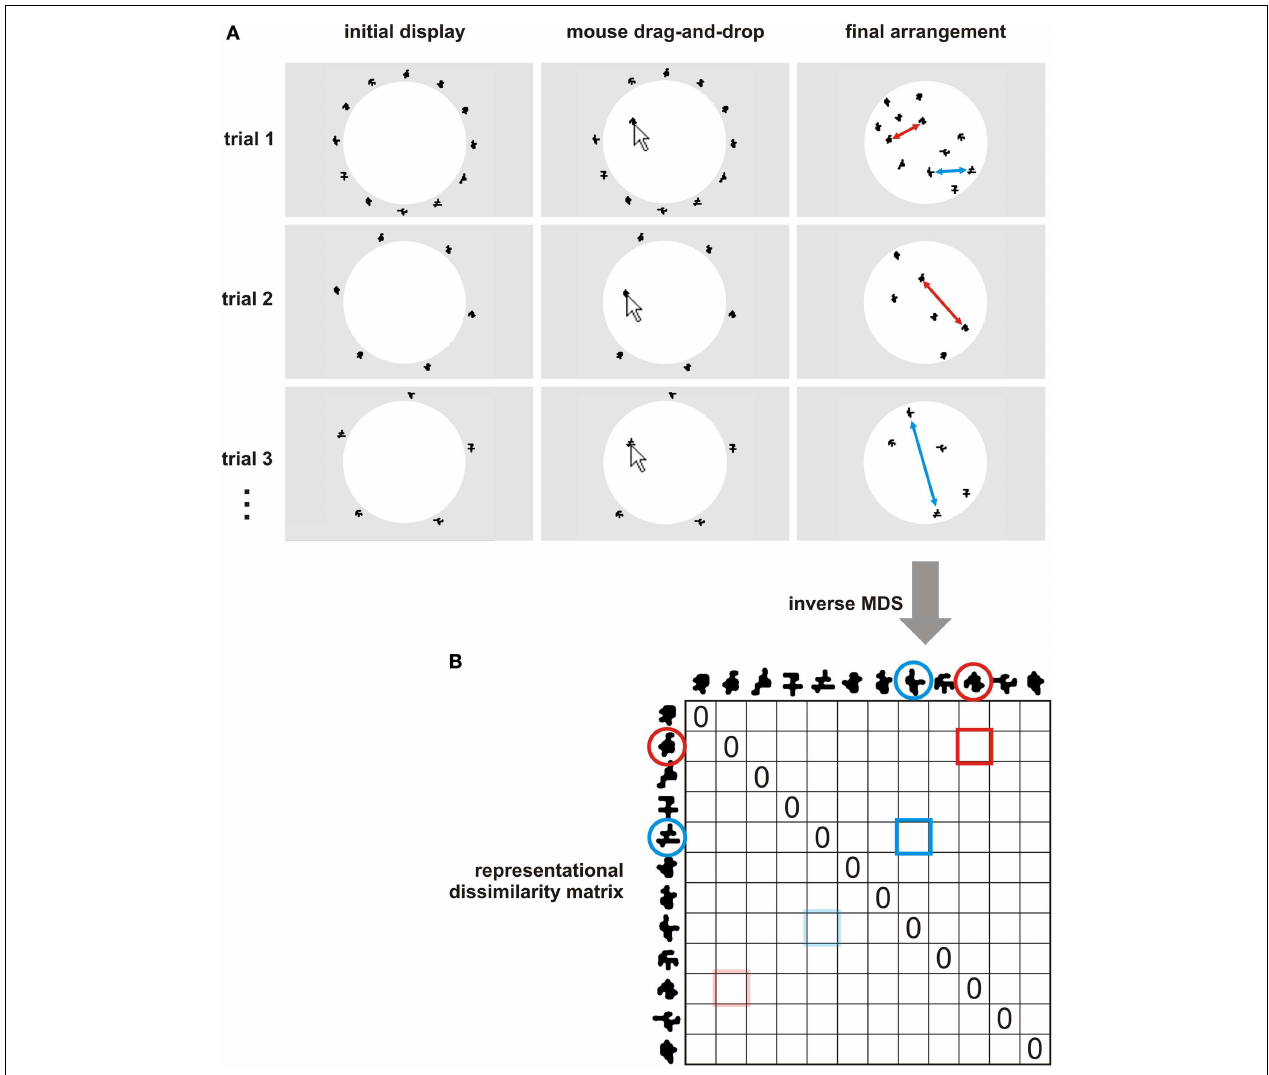
Appendix), which is designed to efficiently sample the evidence for estimation of the representational dissimilarities. (B) The evidence from the multiple 2D arrangements is statistically combined to obtain the estimate of the representational dissimilarity matrix (RDM). See Figure 3 and Estimating the High-Dimensional Dissimilarity Matrix from Multiple Item-Subset Arrangements in Appendix for algorithms.The RDM contains a dissimilarity estimate for each pair of items and is symmetric about a diagonal of zeros.Two example item pairs are shown in red and blue.Their single-trial dissimilarity estimates (red and blue double arrows in (A) ) are combined into a single dissimilarity estimate. Mirror-symmetric entries are indicated by transparent